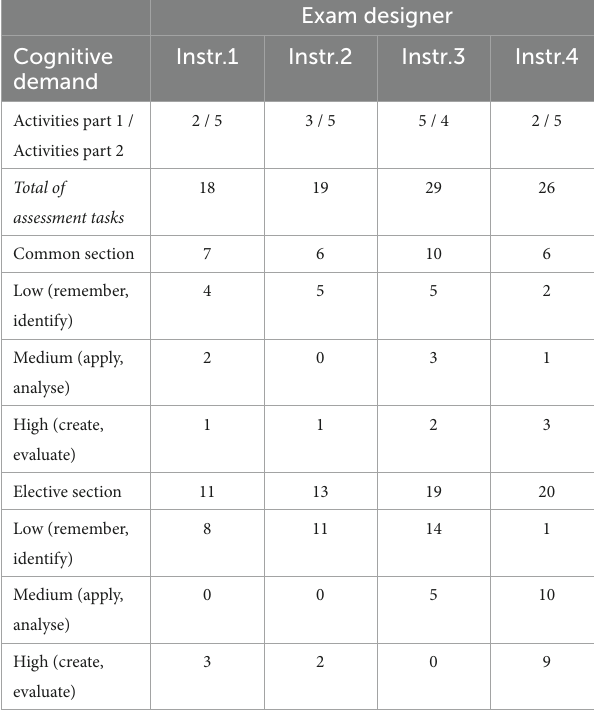
TABLE 2 Quantity of assessment tasks in exams and cognitive demand.